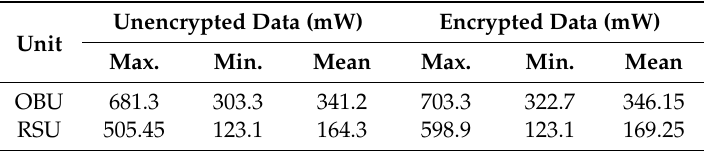
Table 6. Power consumption for data transmission.